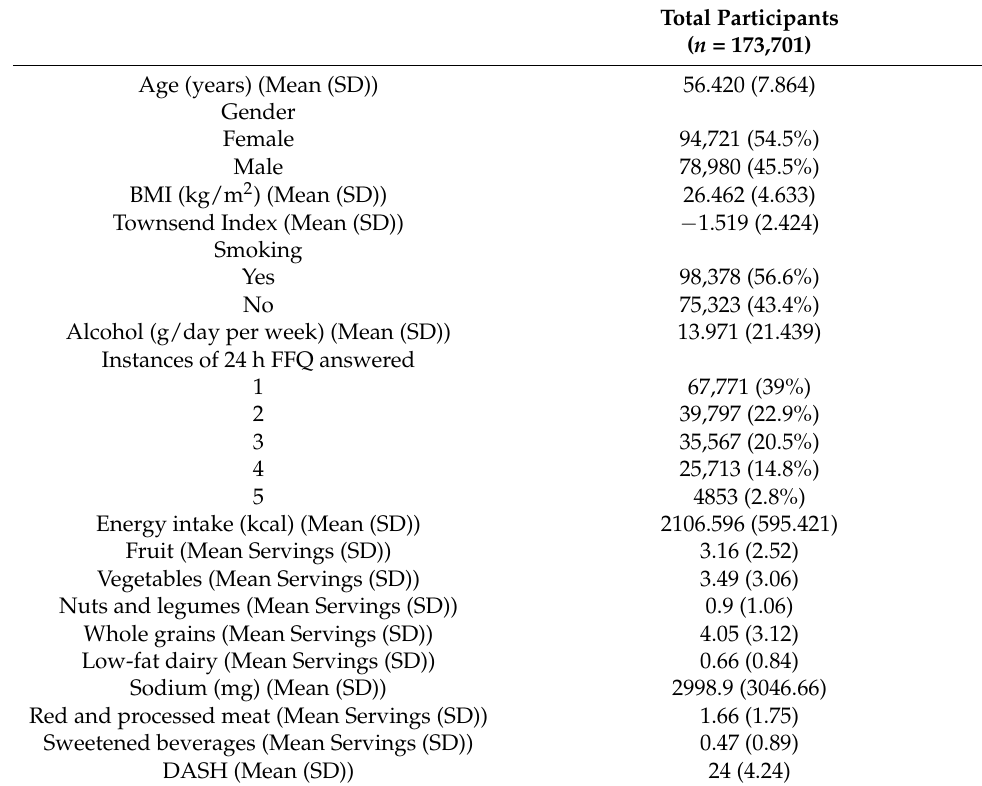
Table 1. Baseline characteristics of the UK Biobank participants included in the GWA